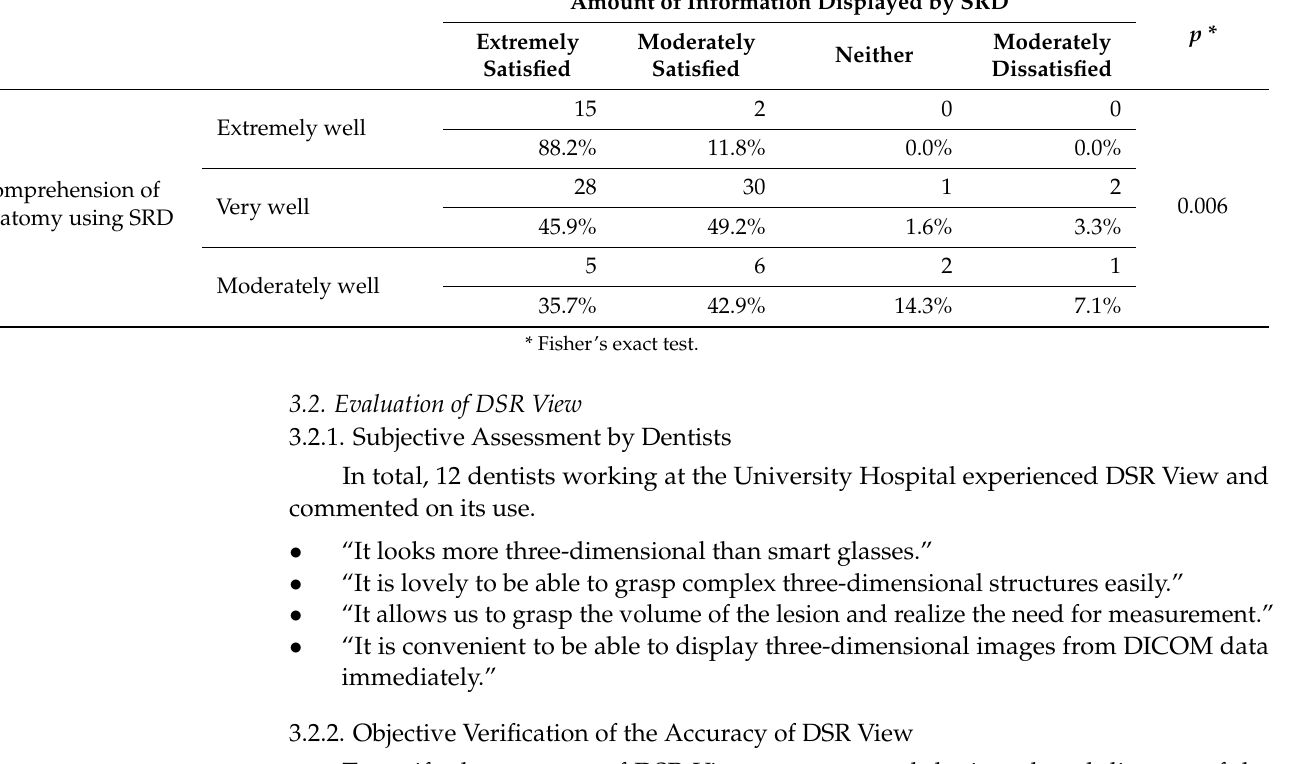
Table 2. Correlation between the comprehension of anatomy and the amount of information displayed by the SRD. Amount of Information Displayed by